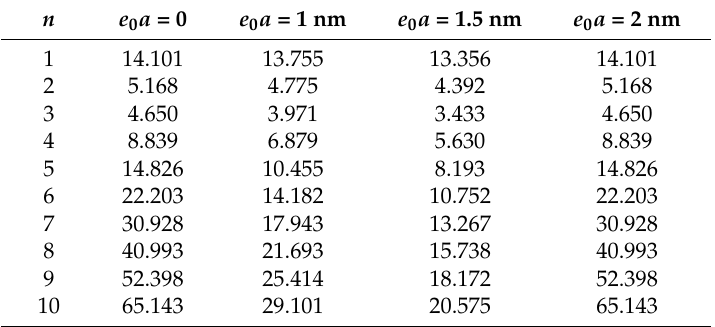
Table 11. Variation of natural frequency ω (GHz) against the circumferential wave number n for different nonlocal parameter e 0 a of FGPM-I